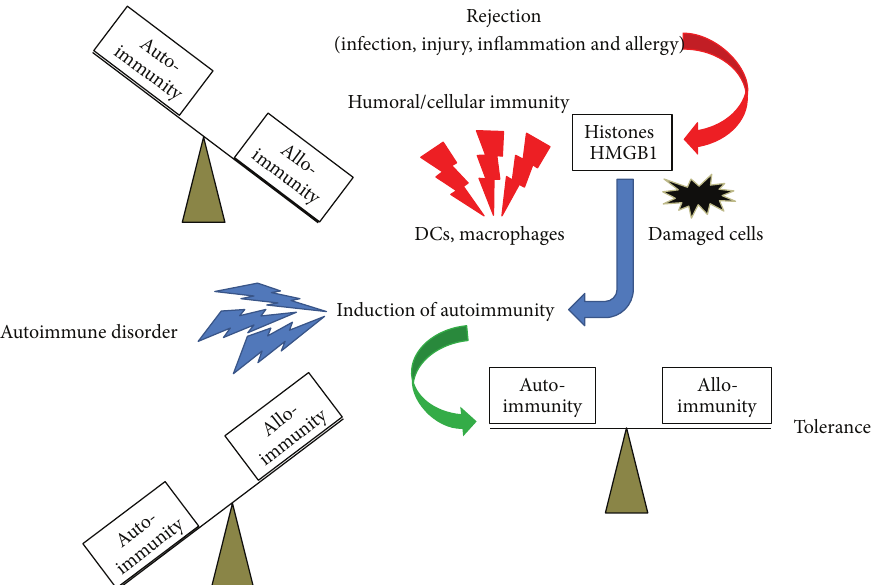
Figure 4: The balance of autoimmunity and alloimmunity (against alloantigens, pathogens, or allergens) is important for immune regulation. During the rejection phase (or when suffering from infection, injury, or allergy), alloimmunity is predominant, and nuclear antigens such as histones and HMGB1 are released from damaged cells, tissues, or organs or are actively secreted from activating immune cells such as DCs and macrophages. The induction of autoimmunity against nuclear antigens (i.e., induction of antinuclear Abregs) may regulate the balance and induce immunological tolerance. Excessive activation of autoimmunity may cause autoimmune